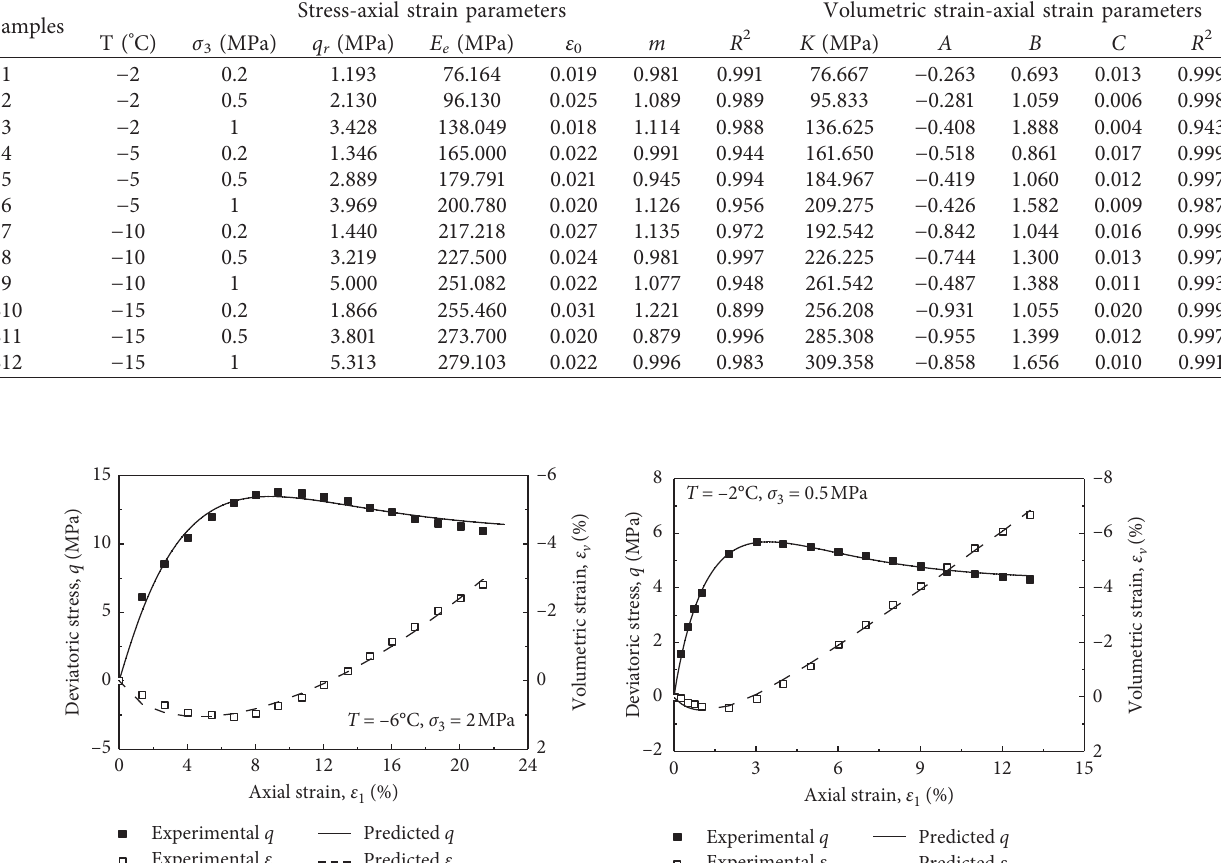
Table 3: Model parameters of the frozen coarse-grained material in this study. Samples